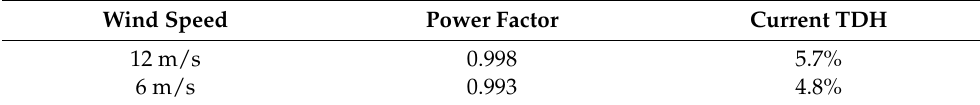
Figure 11. Experimental input voltage and current: ( a ) 40 Hz (v wind = 12 m/s); ( b ) 20 Hz (v wind = 6 m/s). Table 4. SEPIC summary operation: experimental results.